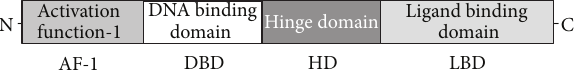
Figure 1: Schematic structure of PPARs protein. The predicted con- sensual important domain structures for each PPAR are depicted, which are common in fish species. AF-1 = activation function-1, DBD = DNA binding domain, HD = hinge domain linking DBD and LBD, LBD = C-terminal ligand binding